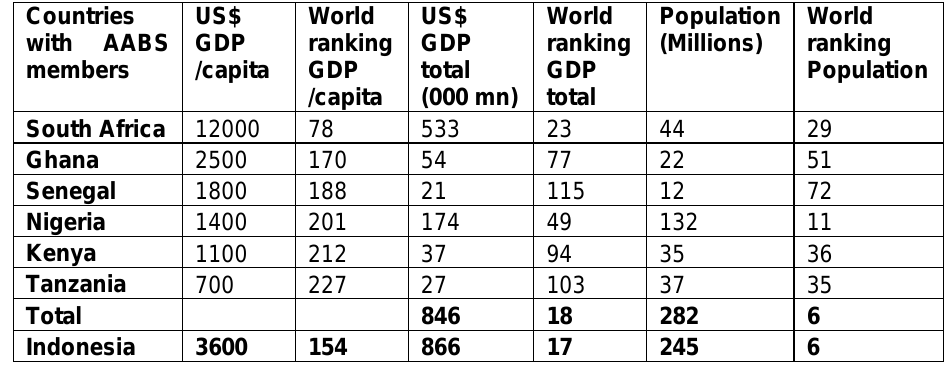
Table 1: Profile of member countries of